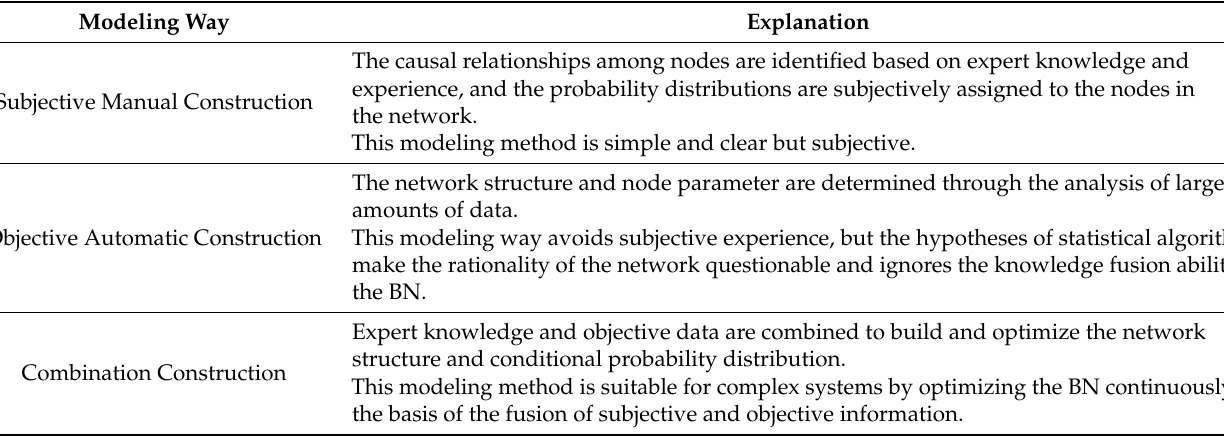
Table 1. Modeling ways of